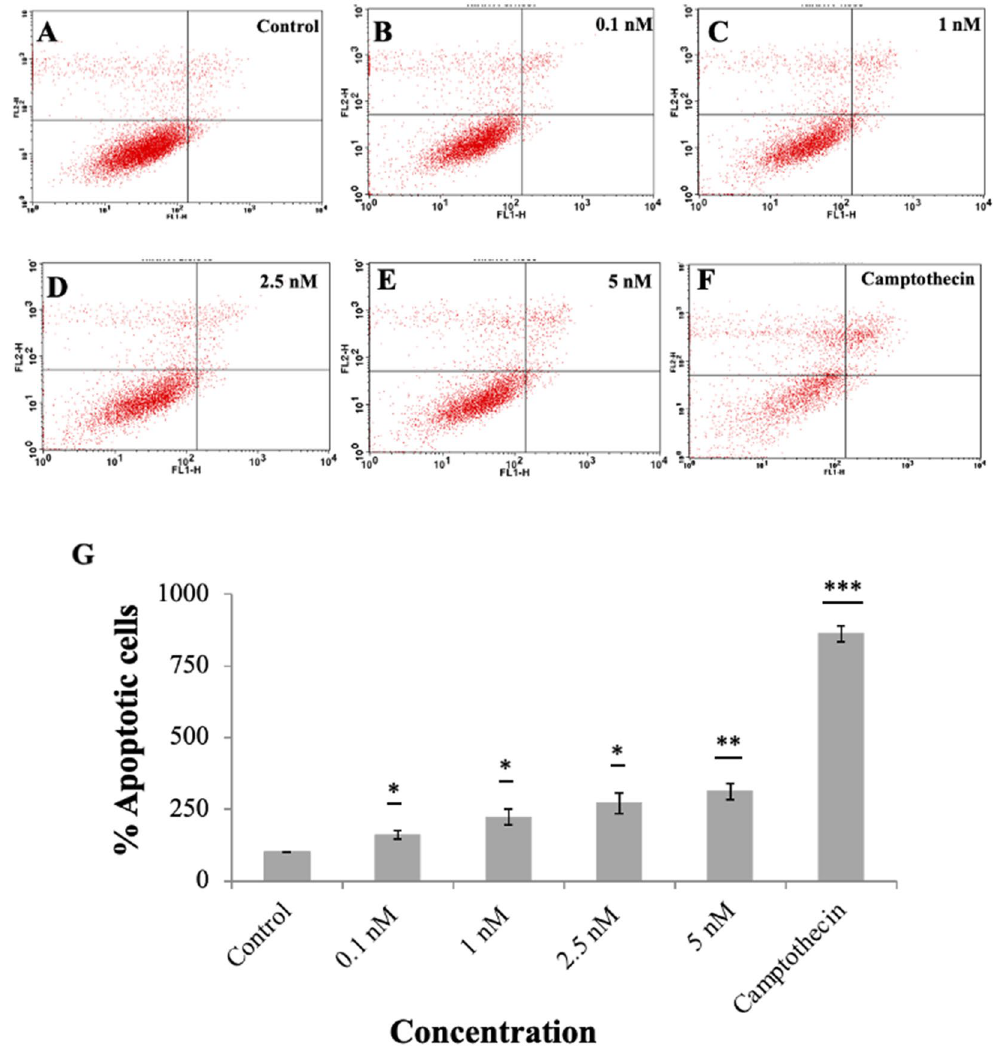
Figure 6. Estimation of apoptosis in MCF-7 cells after treatment. Flow cytometric scatter plot of PI vs Annexin-FITC ( A – E ) various concentration of miRNA coated AuNPs ( F ) Camptothecin (1 µg/mL) was used as positive control. ( G ) Bar graph represents the percent apoptotic population induced by miRNA coated Au Nps. Values represents mean ± S.E. of three independent experiments (*p < 0.05, **p <